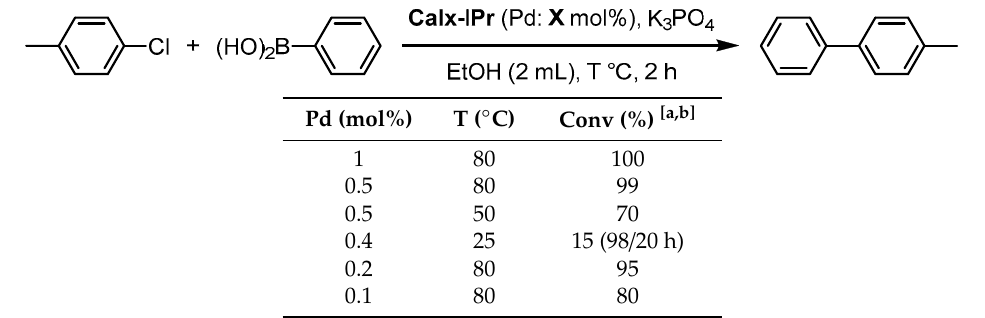
Table 3. Optimization of catalytic loading and temperature in Suzuki–Miyaura cross-coupling reactions catalyzed by Calx-IPr.